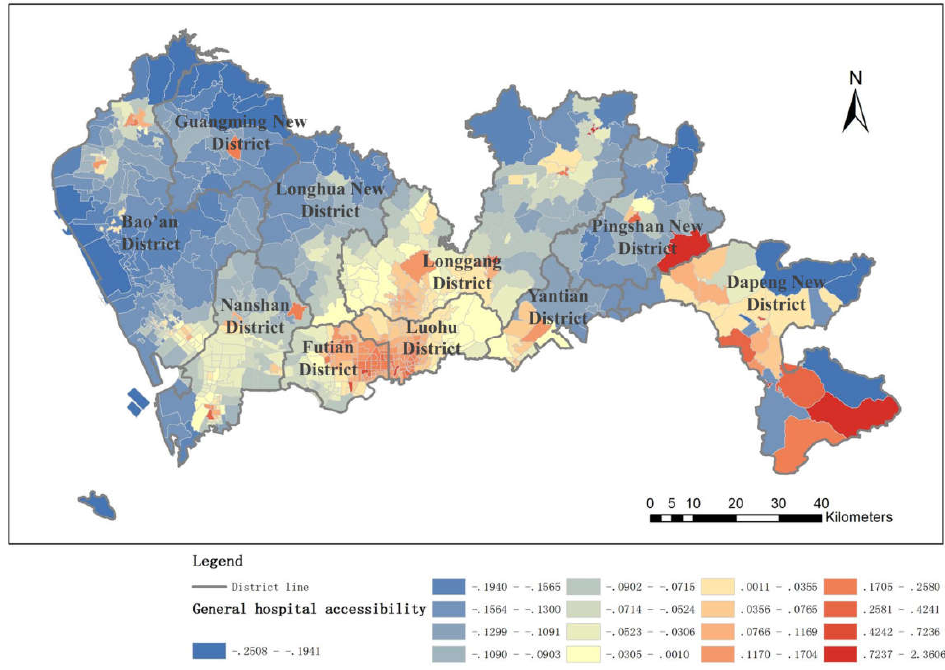
Figure 9. General hospital accessibility.